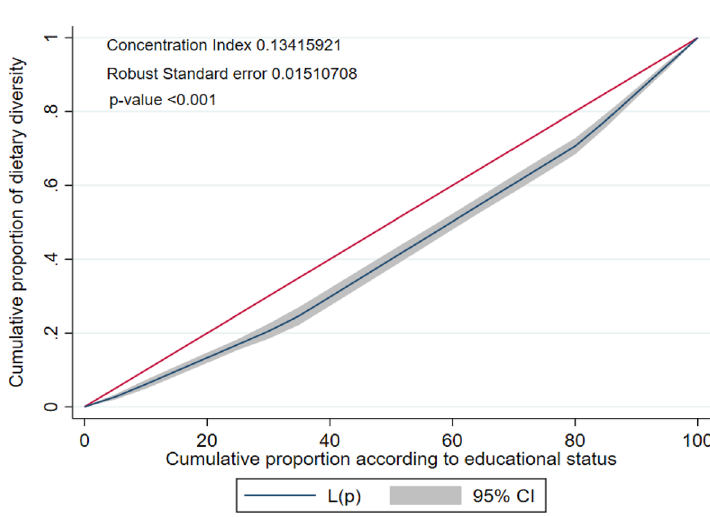
Figure 4. Concentration curve of dietary diversity against the education